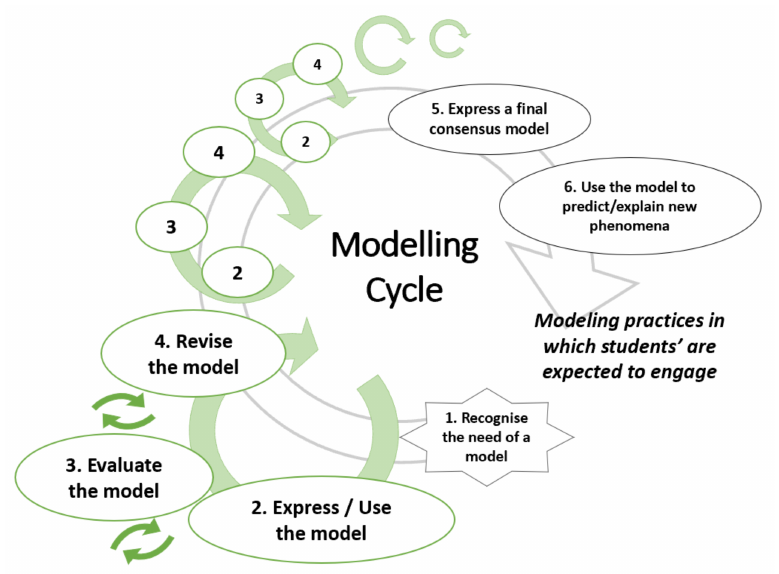
Figure 1. Pupil modeling practices promoted by the modeling cycle of Couso and Garrido- Espeja